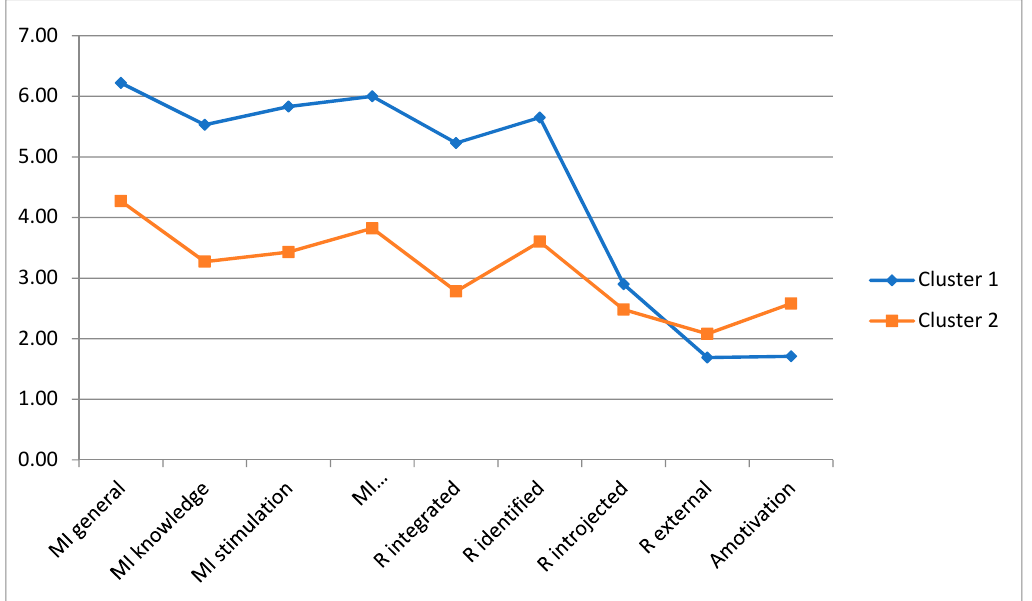
Figure 3. Analysis of Hierarchical Conglomerates with Ward Method in the Total Sample. Note: MI = Intrinsic motivation; R = Regulation; Cluster 1 = Self-Determined; Cluster 2 = Less Self-Determined.